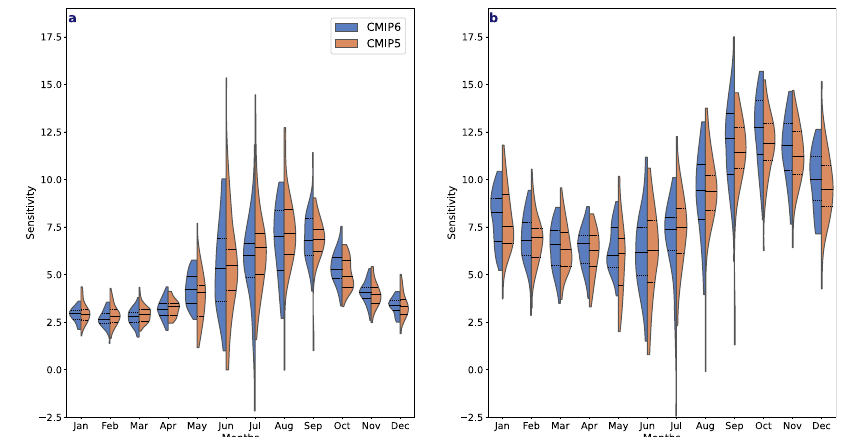
Fig. 4 Sensitivity of precipitation to temperature change throughout the twenty- fi rst century. The percentage change of total precipitation per degree of a Arctic warming and b Global warming by month. The black dashed lines represent the 25th – 75th percentile and the black solid lines represent the model mean following the SSP5 – 8.5/RCP8.5 scenarios for CMIP6 (blue) and CMIP5 (orange).